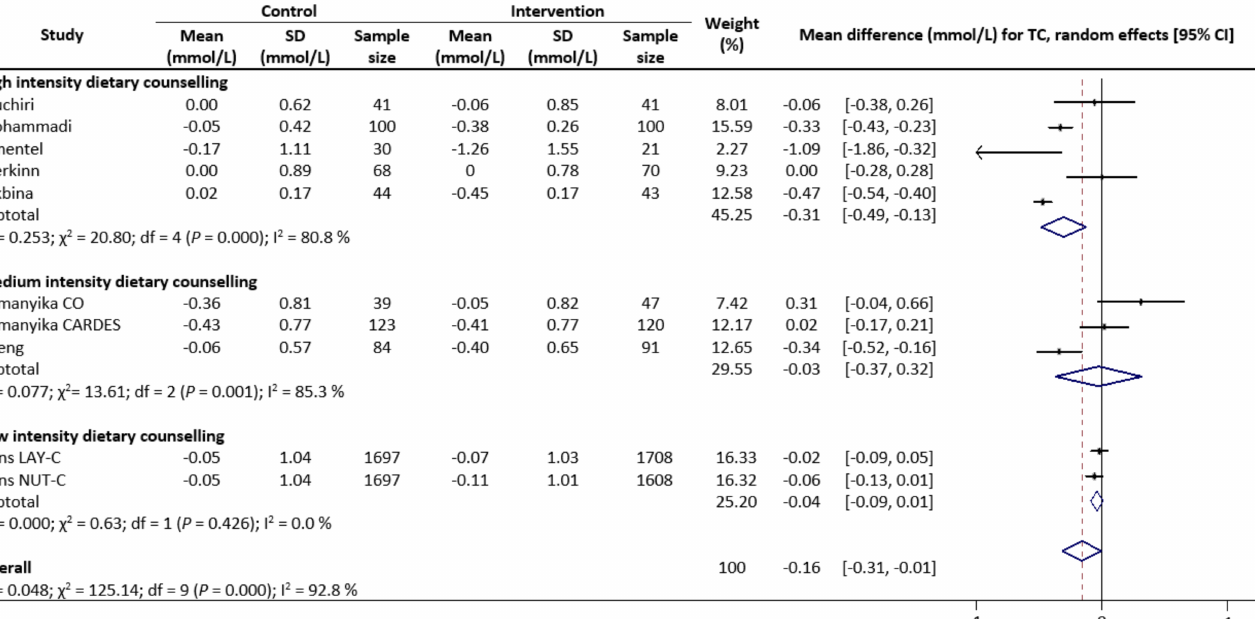
Figure 4. Random-effects model meta-analysis for comparing the changes in TC of RCTs providing dietary counselling compared to not providing dietary counselling and subcategory analysis in accordance with the intensity level for dietary counselling. Each study is identified by author and year. The horizontal line represents the effect size for each study and the whiskers extending on both sides represent the study effect’s 95% CI. The diamond indicates the overall effect size. Abbreviations: AC, group A and group C; BD, group B and group D; BC, group B and group D; AD, group A and group D; CO, counselling only; CARDES, components of cardiovascular dietary education system; LAY-C, lay person counselling; NUT-C, nutritionist